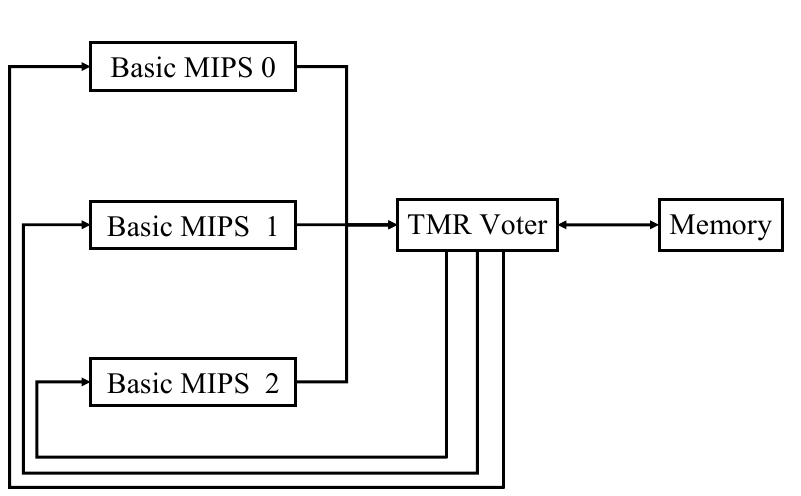
Figure 1. Triple Modular Redundancy (TMR) MIPS simplified block diagram.